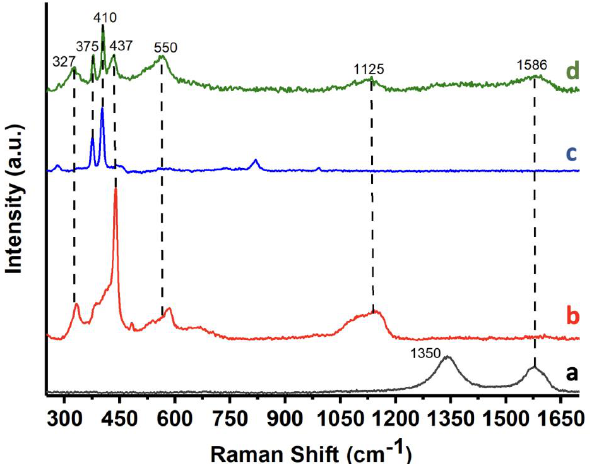
Figure 3. Raman spectra of rGO ( a ); ZnONPs ( b ); MoS 2 ( c ); and 5%Au@ZnONPs-3%MoS 2 -1%rGO ( d ). Figure 4 depicts the X-ray diffraction (XRD) pattern of the 5%Au@ZnONPs-3%MoS 2 - 1%rGO catalyst, alongside those of ZnONPs, 5%Au@ZnONPs, MoS 2 , and rGO for com- parative purposes. The diffraction peaks of the ZnONPs (Figure 4a) can be unambigu-